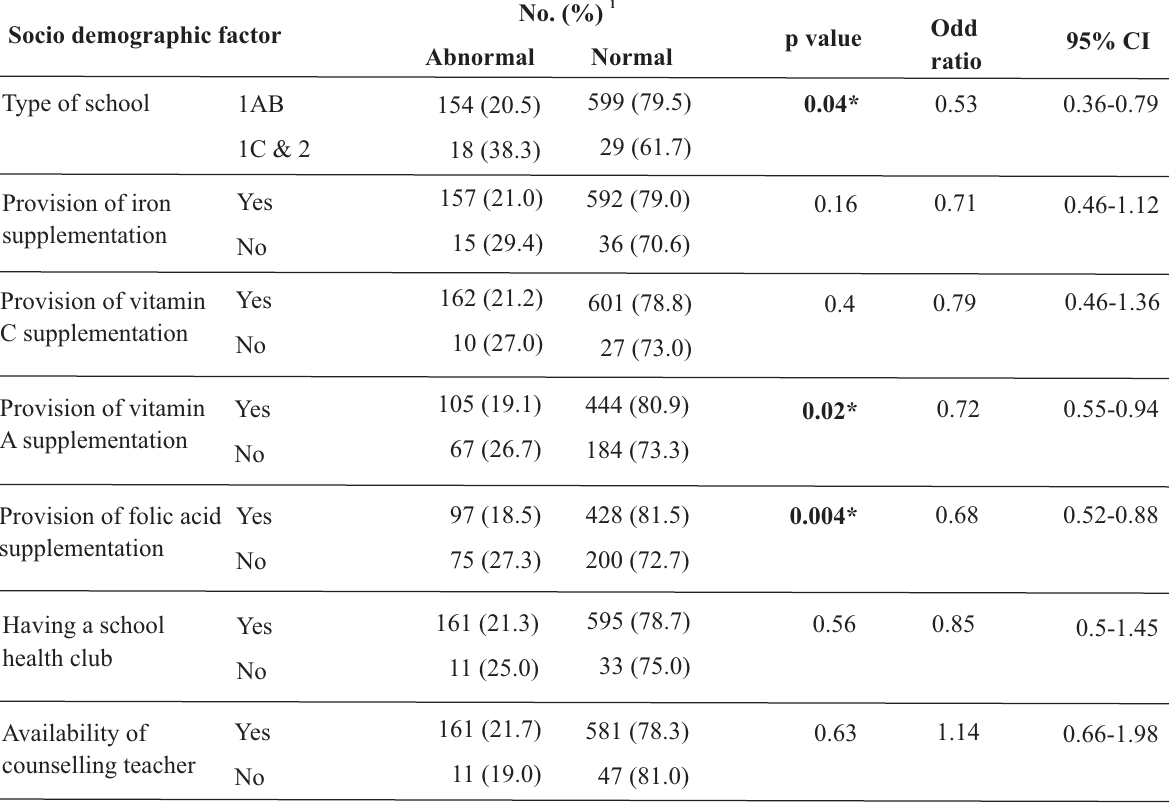
Table 3: Relationship between mental health status and school level activities Socio demographic